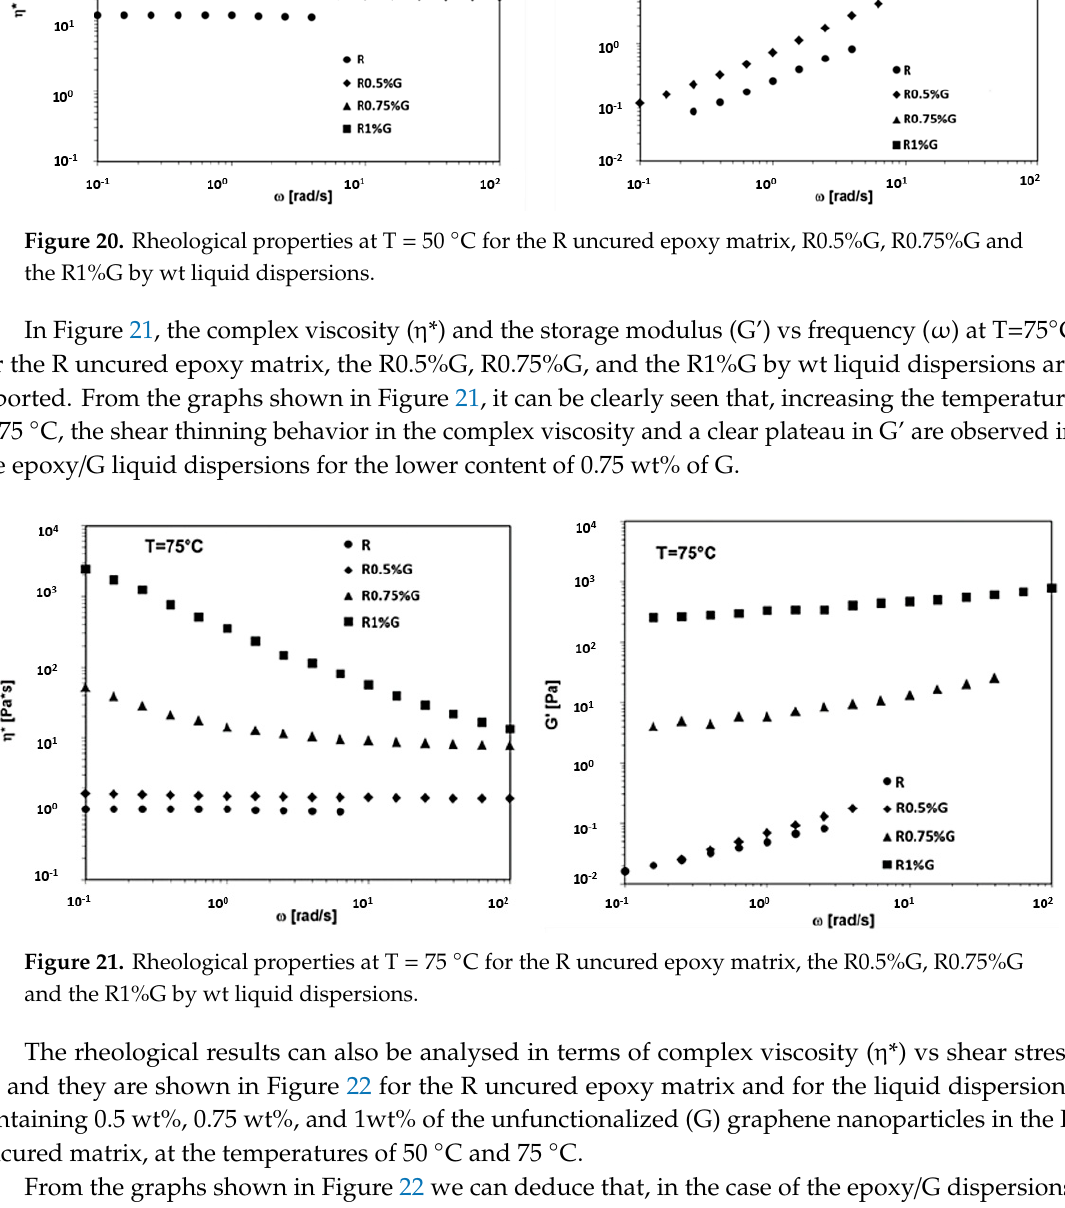
Figure 22. Complex viscosity vs shear stress at T = 50 °C and T = 75 °C for the R uncured epoxy matrix, the R0.5%G, R0.75%G and the R1%G by wt liquid dispersions. Moreover, it is noteworthy that the presence of edge-carboxylation of the graphitic material decreases the rheological percolation threshold to values similar to those observed for the mono- dimensional MWCNTs fillers [33]. Finally, the complex viscosity ( η *) vs frequency ( ω ) for the liquid dispersions containing an amount of 0.5 wt% of the unfunctionalized (G) and functionalized (G-py) graphene nanoparticles in